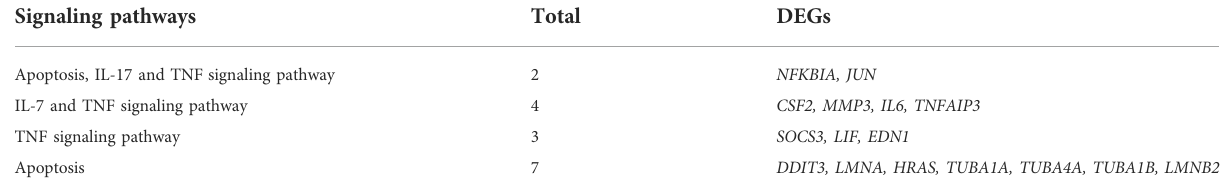
TABLE 3 DEGs in KEGG signaling